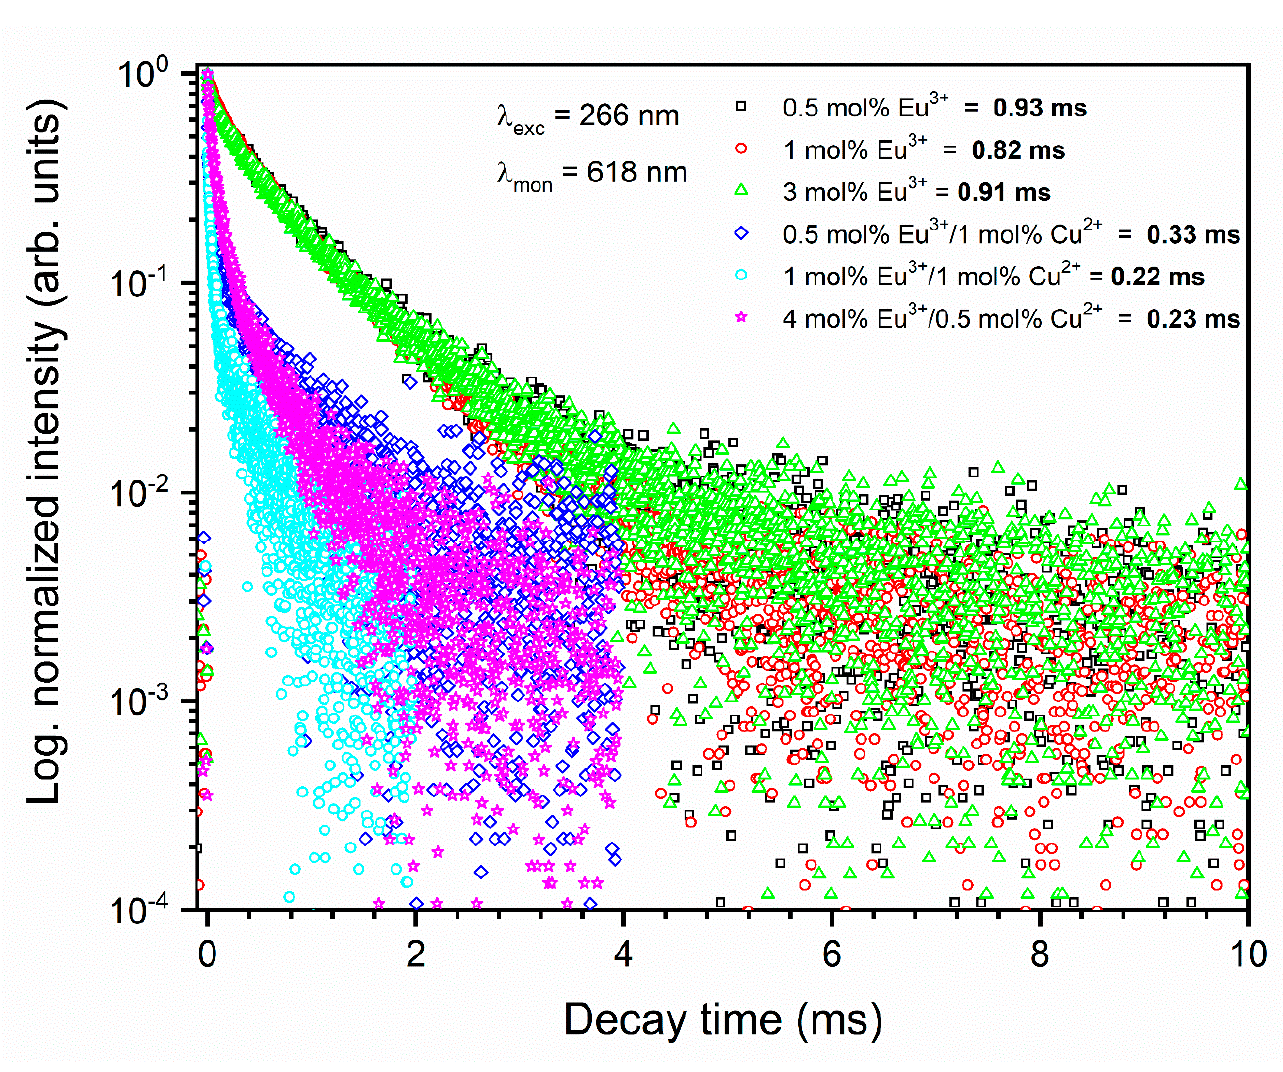
Figure 9. Decay times of the Eu 3+ -doped and Eu 3+ /Cu 2+ co-doped Ca 10 (PO 4 ) 6 (OH) 2 . The obtained efficiency is equal to 65 and 73% for 0.5 mol% Eu 2+ /1 mol% Cu 2+ and 1 mol% Eu 2+ /1 mol% Cu 3+ co-doped HAp, respectively. The observed